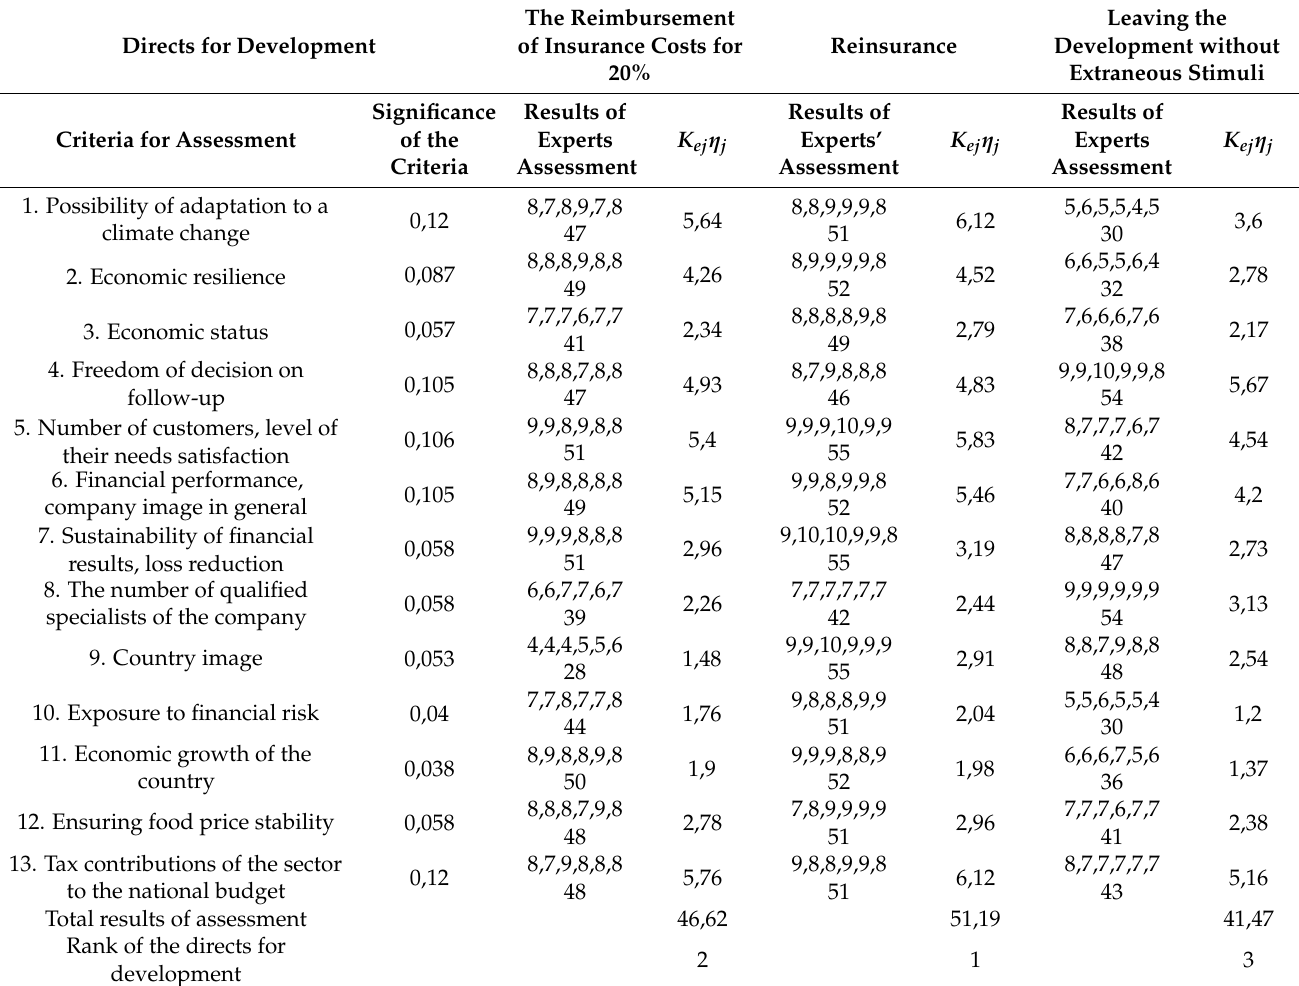
Table 5. Results of experts’ assessment directions for public authorities’ activity